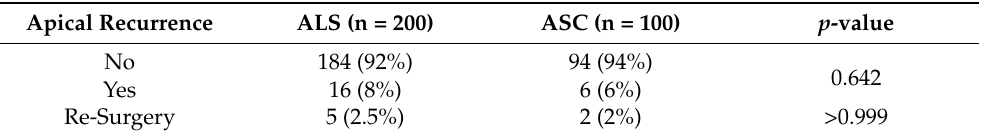
Table 3. Anatomical outcomes in the apical compartment based on clinical evaluation with a sim- plified POP-Q measurement as defined by IUGA-ICS prolapse staging. Age and BMI were used to select 300 patients, with ALS/ASC ratio equal 2, from a population of 360 patients by propensity score method. Data are presented as frequency (%). Simplified POP-Q values comparing ALS vs. ASC before surgery and after surgery were statistically analyzed with a two-tailed Fisher’s exact test. p -values < 0.05 were considered statistically significant. POP-Q: Pelvic Organ Prolapse Quantification System; IUGA-ICS: International Urogynecological Association—International Continence Society;